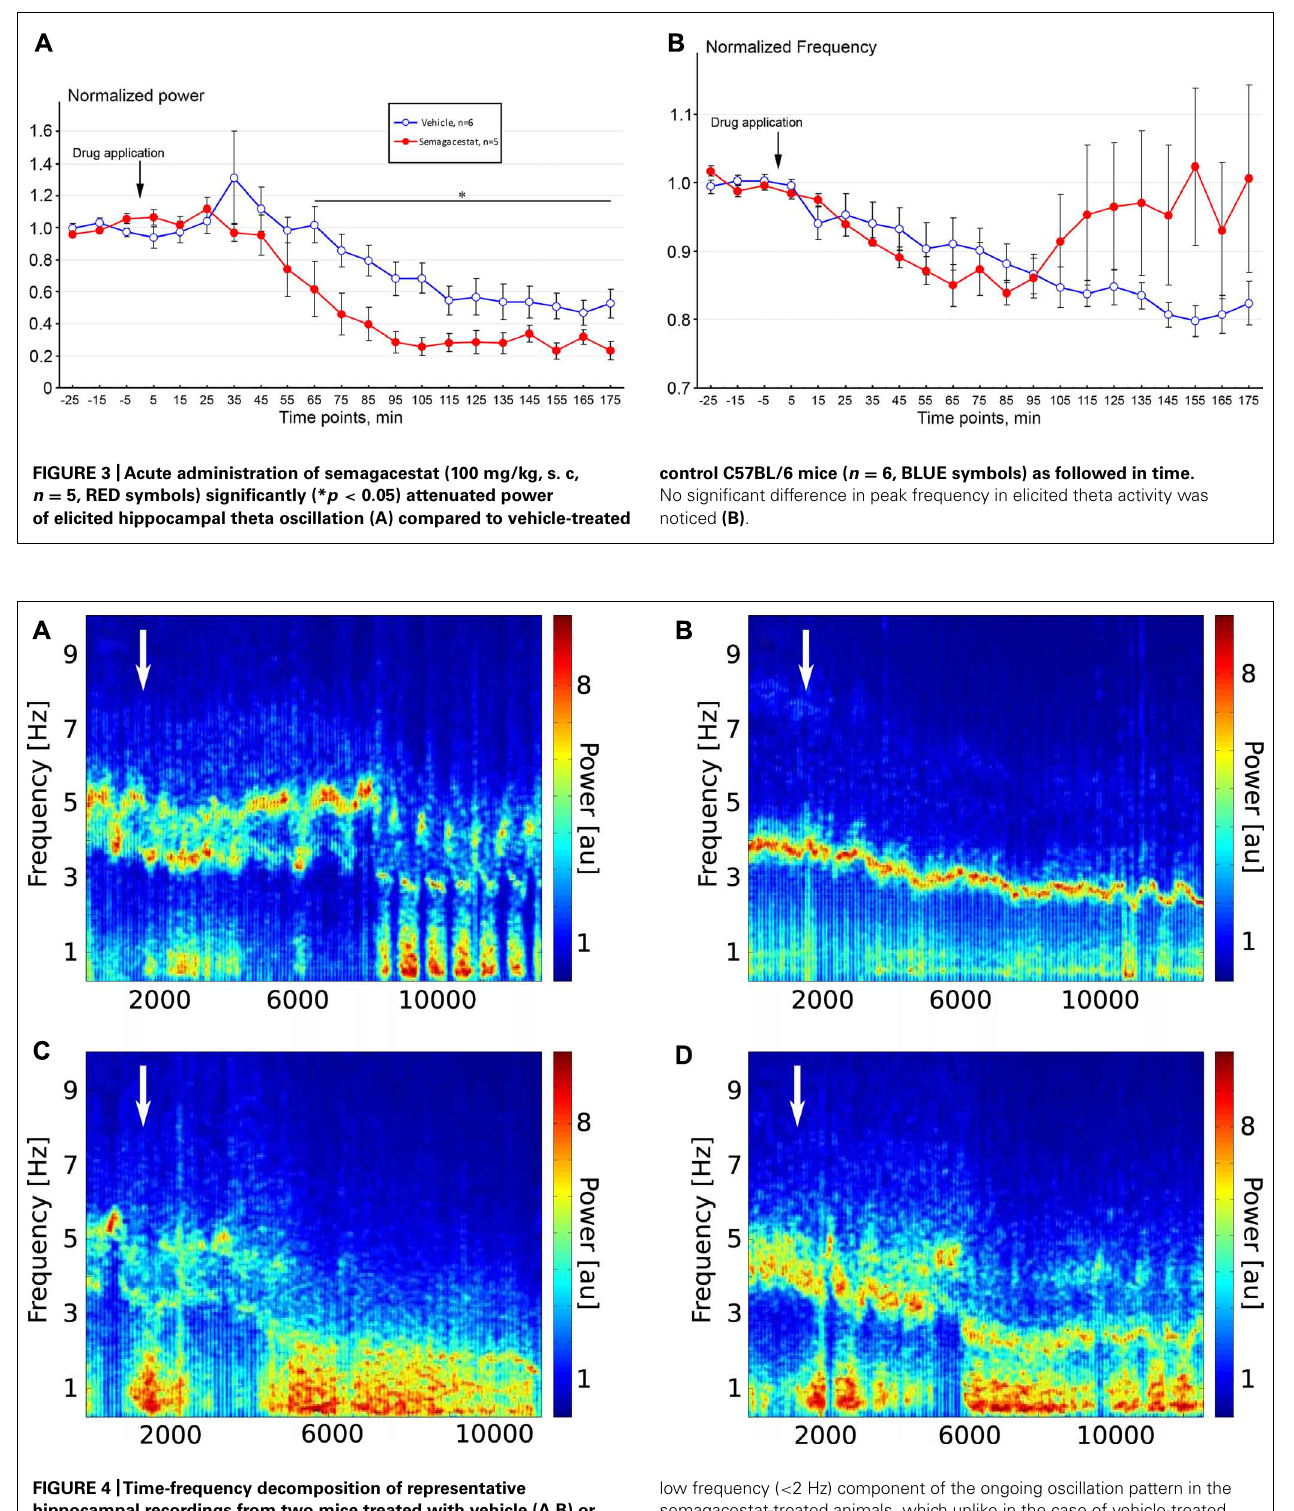
low frequency ( < 2 Hz) component of the ongoing oscillation pattern in the semagacestat-treated animals, which unlike in the case of vehicle-treated animals does not give place to the regular 4–5 Hz theta rhythm during stimulation